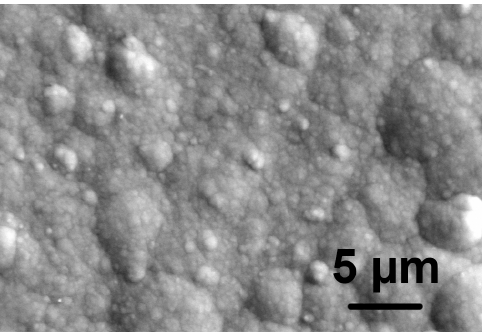
Figure 1. SEM micrograph of the as-deposited Ni-P coating. Note the relatively smooth surface of the coating prior to the acidic treatment.